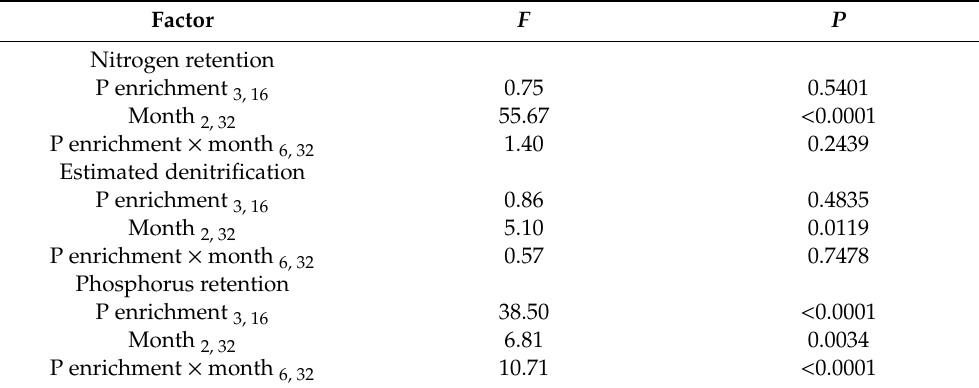
Table 1. E ff ects of P enrichment and month on vegetated mesocosm N retention, estimated denitrification, and P retention. F values and associated P values are based on linear mixed-e ff ect models that incorporated random e ff ects to account for repeated measures within each mesocosm.